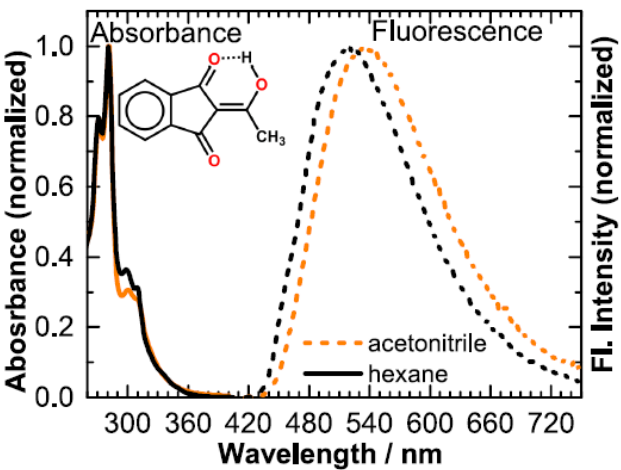
Figure 4. Absorption (solid) and emission spectra (dashed, excitation wavelength 300 nm). Taken